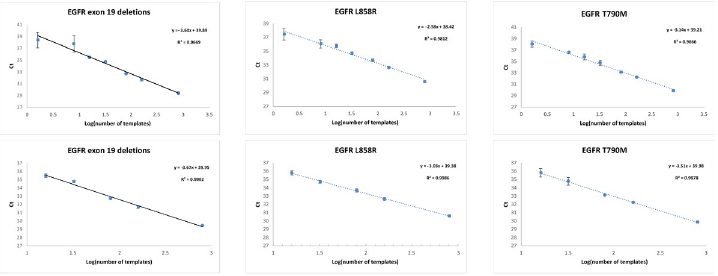
Fig 2. Assessment of platform sensitivity, linearity and PCR efficiency for the SensiScreen 1 EGFR Liquid assays. Logarithmic transformed DNA input (X-axis) according to detection cycle threshold (Y-axis) for assays.